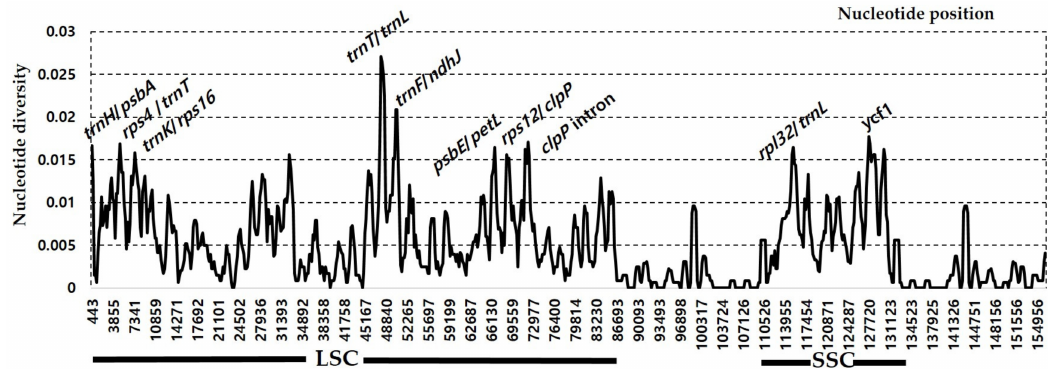
Figure 5. Sliding window analysis of the whole chloroplast genomes of four Rubus species ( R. boninensis , R. trifidus, R. crataegifolius , and R. takesimensis ).